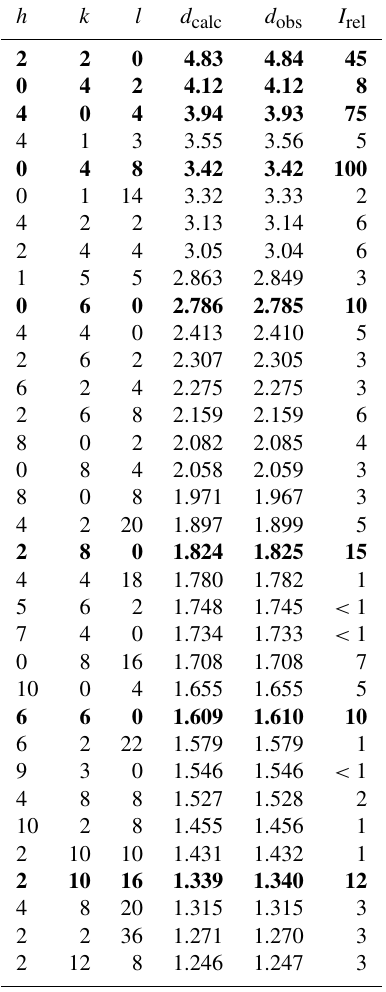
Table 3. Powder X-ray data for of tancaite-(Ce). The refined unit cell is a = 19 . 305 ( 1 ) , c = 47 . 438 ( 5 ) , and space group R ¯ 3. The eight strongest reflections are reported in